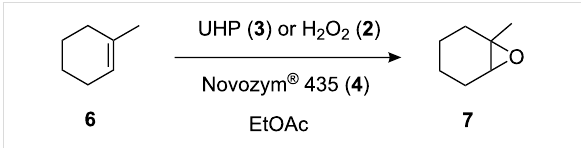
Scheme 3: Model reaction used to compare the continuous flow epox- idation strategy with the conventional batch technique.